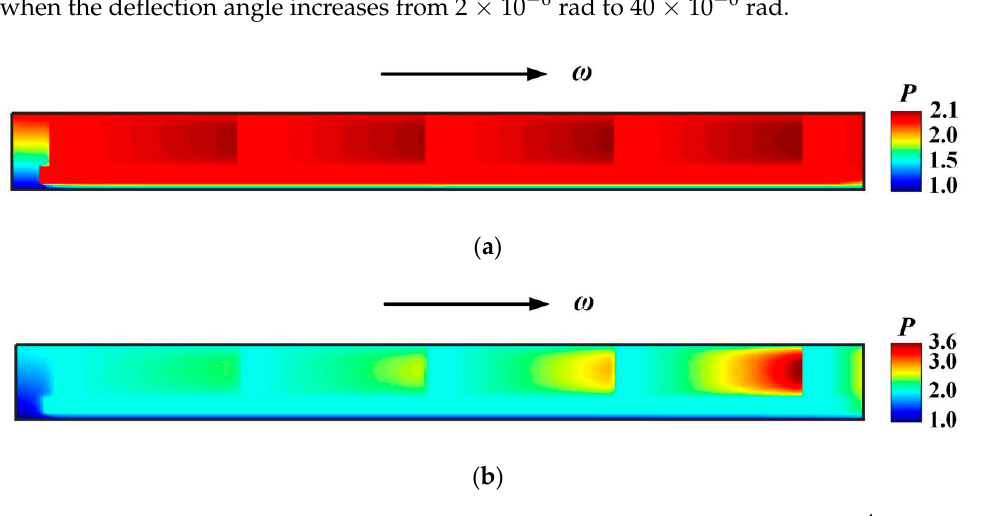
Figure 15. Pressure distribution at different deflection angles. ( p i = 0.2 MPa, ω = 3.0 × 10 4 r/min, T in = 580 K, T out = 420 K); (a) β =2 × 10 − 6 rad; (b) β = 40 × 10 − 6 rad.